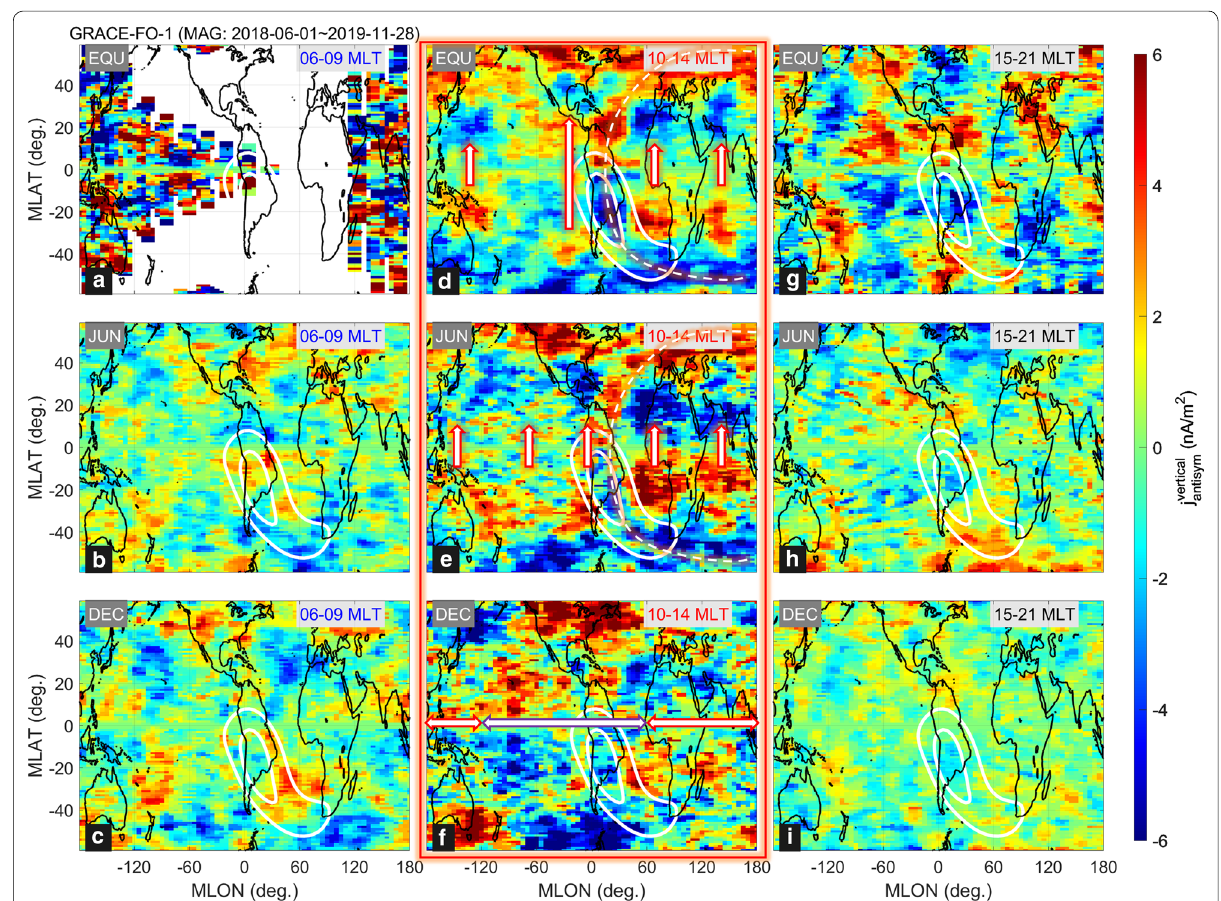
Fig. 9 The same as Fig. 8, but for GRACE-FO1. The locations of the horizontal/vertical arrows and C-shaped curves for annotation are the same as in Fig. 8 for the purpose of a direct